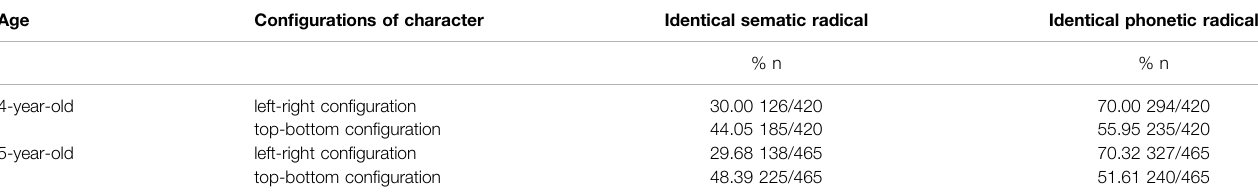
TABLE 4 | Four to- fi ve-year-old children ’ s percentage of choices for the identical radical. Age Con fi gurations of character Identical sematic